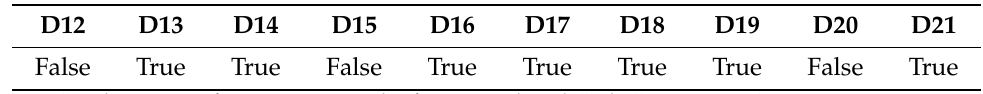
Table 8. Selected features II.